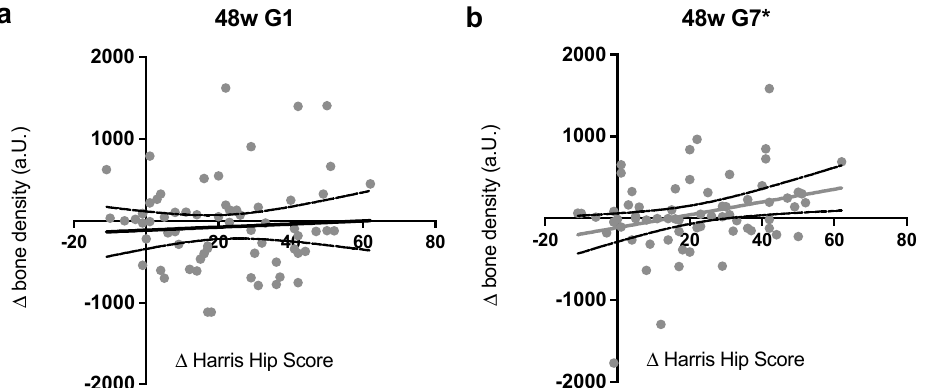
Figure 6. The correlation of clinical and radiographic development after 48 weeks ( a ) in G1; ( b ) in G7 (significant * p < 0.05). The bone density in the proximal zones G1 and G7, which showed previously the biggest adjustments after MRP-TITAN, and the difference in Harris hip scores 48 weeks after implantation showed a clear positive dependence. Especially in G7, a significant correlation (* p < 0.05) with a Pearson correlation coefficient of 0.302 could be found for both parameters. This suggests that, for the clinical outcome during the first year after the MRP-TITAN implantation, the development of the proximal periprosthetic bone segment is crucial.